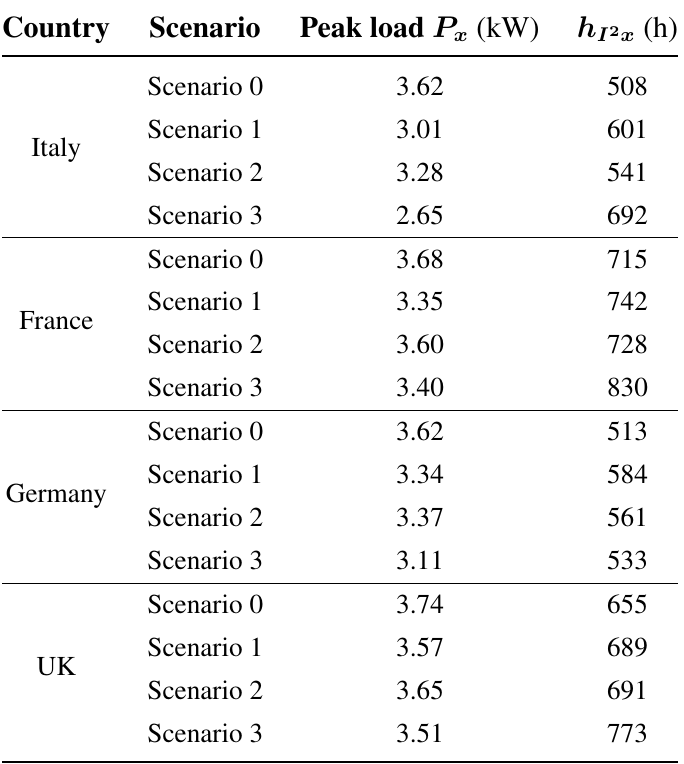
for each country and each I 2 x